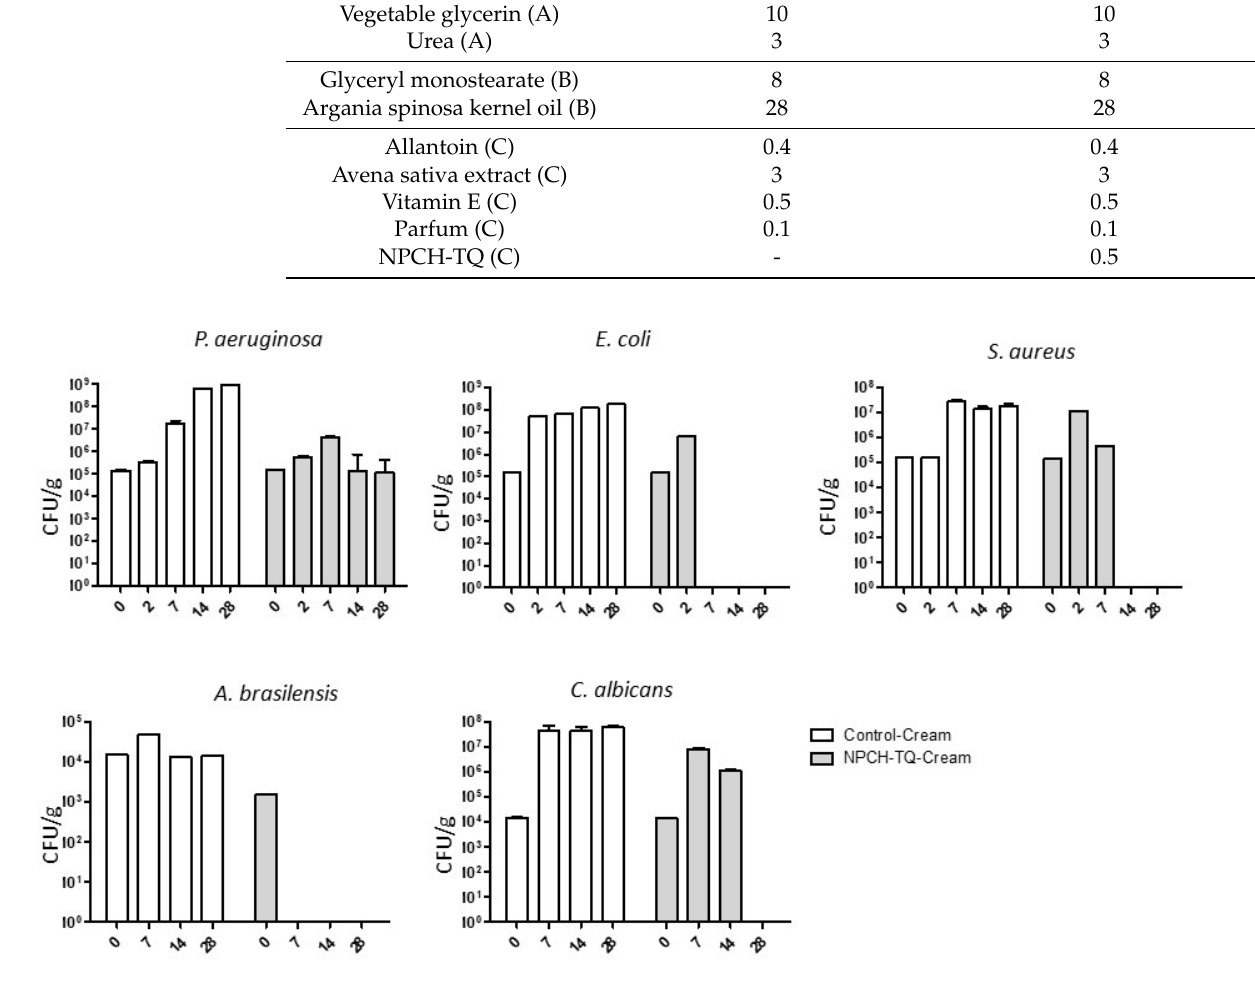
Figure 4. Preservative activity of control cream vs. NPCH-TQ.